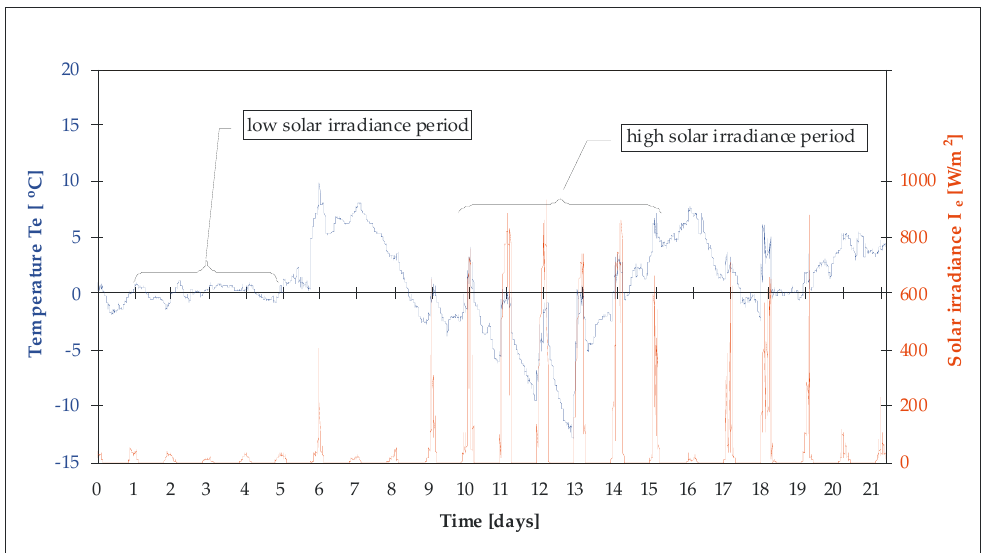
Figure 7. Air temperature distribution vs. solar irradiance recorded outside the test chamber in analyzed period.